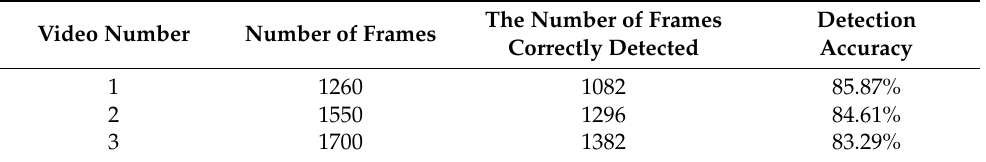
Table 5. Edge based on canny operator detection method detection result.